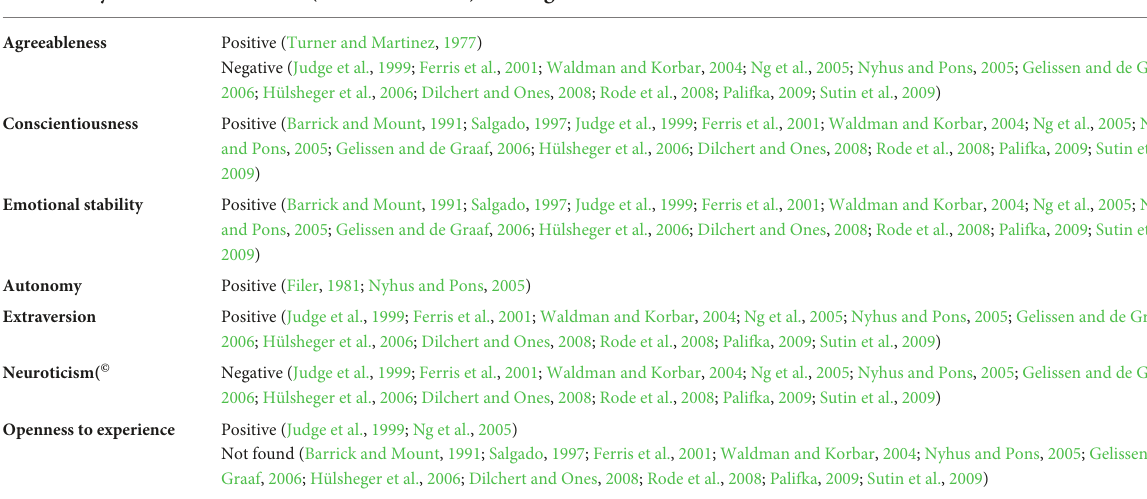
TABLE 2 Correlations between personality traits in the Big Five and the annual income. Personality traits Effect on (association with)